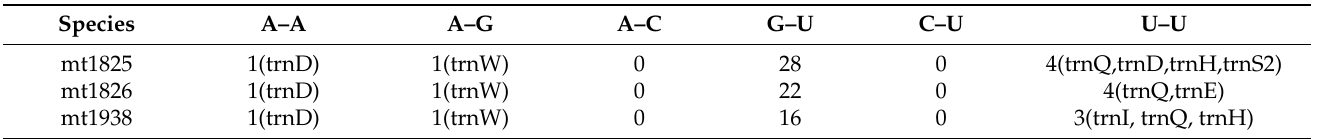
Table 3. Total numbers of different types of base mismatches in tRNAs of the three newly se- quenced